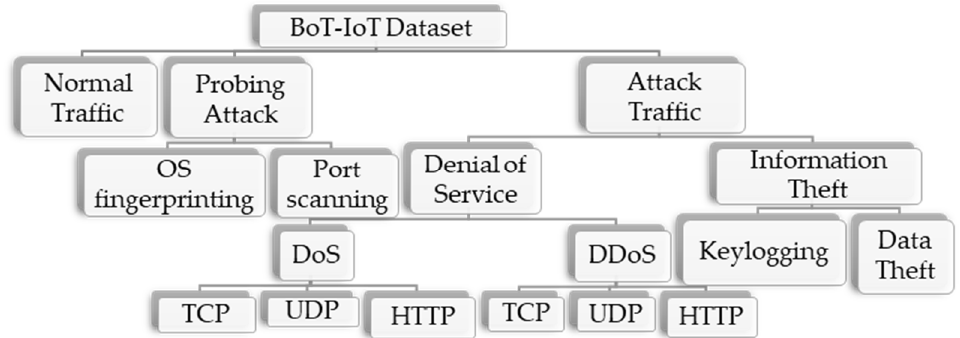
Figure 2. Bot-IoT dataset classification.